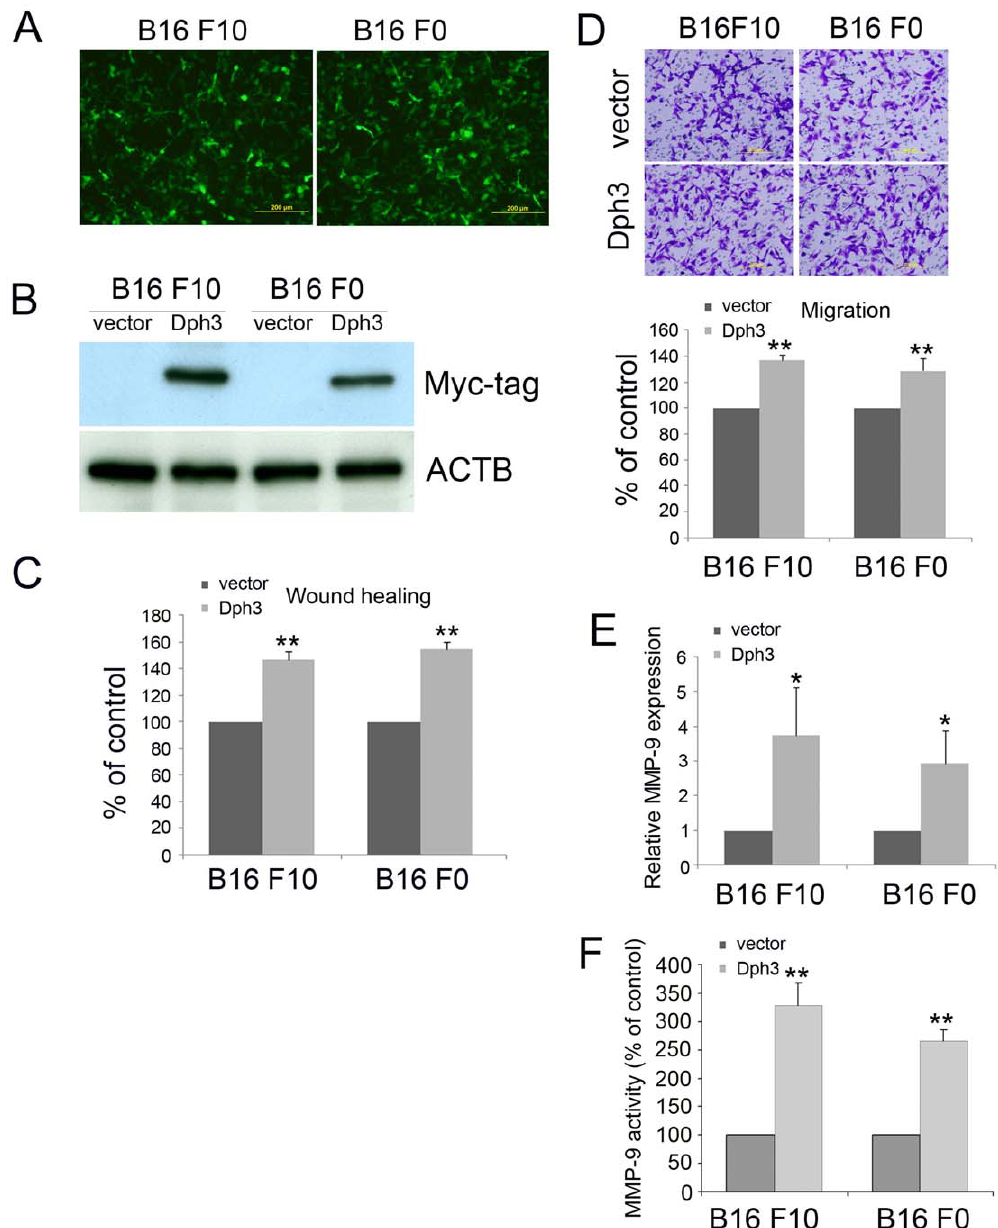
Figure 3. Dph3 overexpression promotes the migration of melanoma B16F10 and B16F0 cells. Dph3 was cloned into pIRES2-EGFP vector and transfected into melanoma B16F10 and B16F0 cells. The cells transfected with an empty vector were used as control. The transfection efficiency was evaluated by the expression of green fluorescence protein (GFP) (A) and the expression of Dph3 was determined western blot with Myc-tag antibody (B). Scale bars: 200 m m. b -actin was used as a loading control. The cell motility was determined by wound healing assay 18 h post scratching and the percentage of wound closure was quantified (C). D, the cell motility was evaluated by transwell assays. Scale bars: 200 m m. E, real-time PCR was carried out to evaluate the mRNA expression level of MMP-9 in control and Dph3 overexpression cells. F, activity of MMP-9 in control and Dph3 overexpression cells was determined by MMP-9 activity assay. Data are from three independent experiments and are average 6 S.E. values. *p , 0.05, **p , 0.01, compared to control